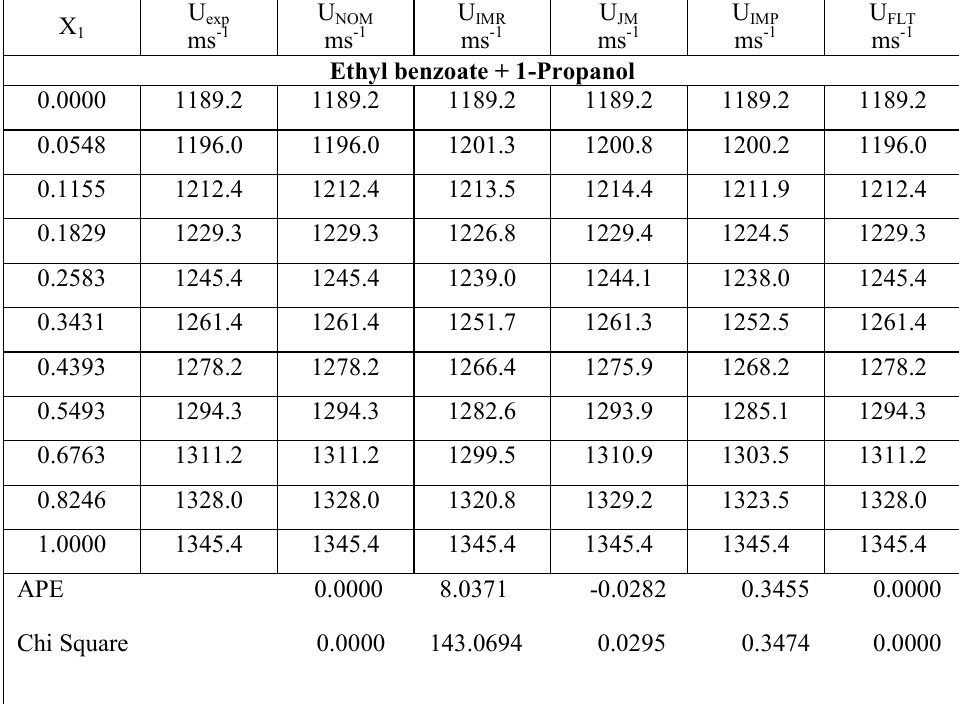
Table 1. Experimental and computed values of Ultrasonic velocity for different systems at